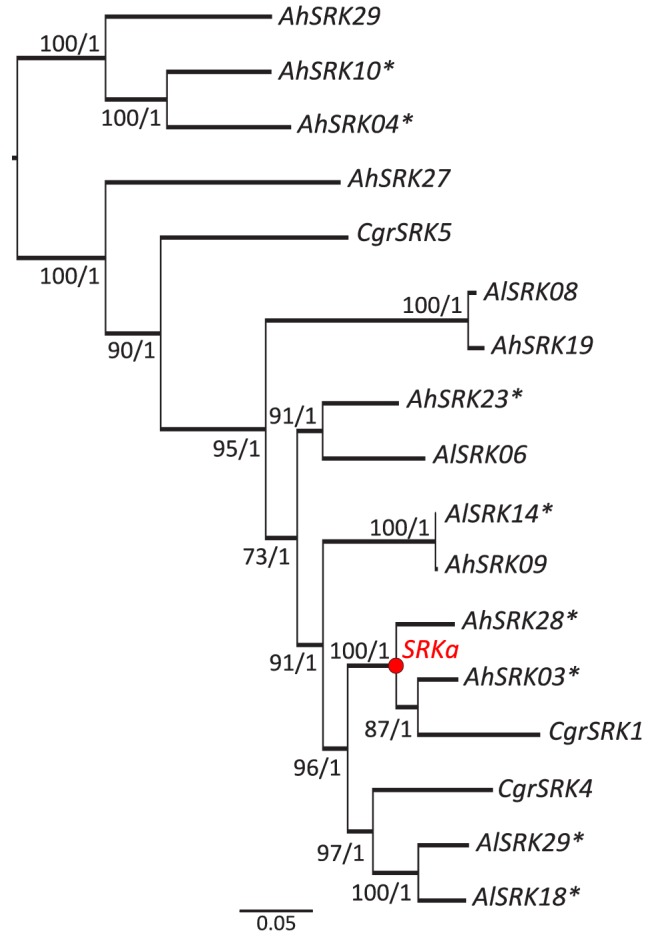
Maximum likelihood phylogenetic tree based on the 17 SRK alleles used for SRKa construction.The Bayesian reconstruction displays an identical topology. Values at the branches represent the bootstrap percentage/posterior probabilities. The node representing the reconstructed ancestral SRK allele (SRKa) is shown in red. Asterisks highlight alleles with a complete sequence available for ancestral reconstruction.